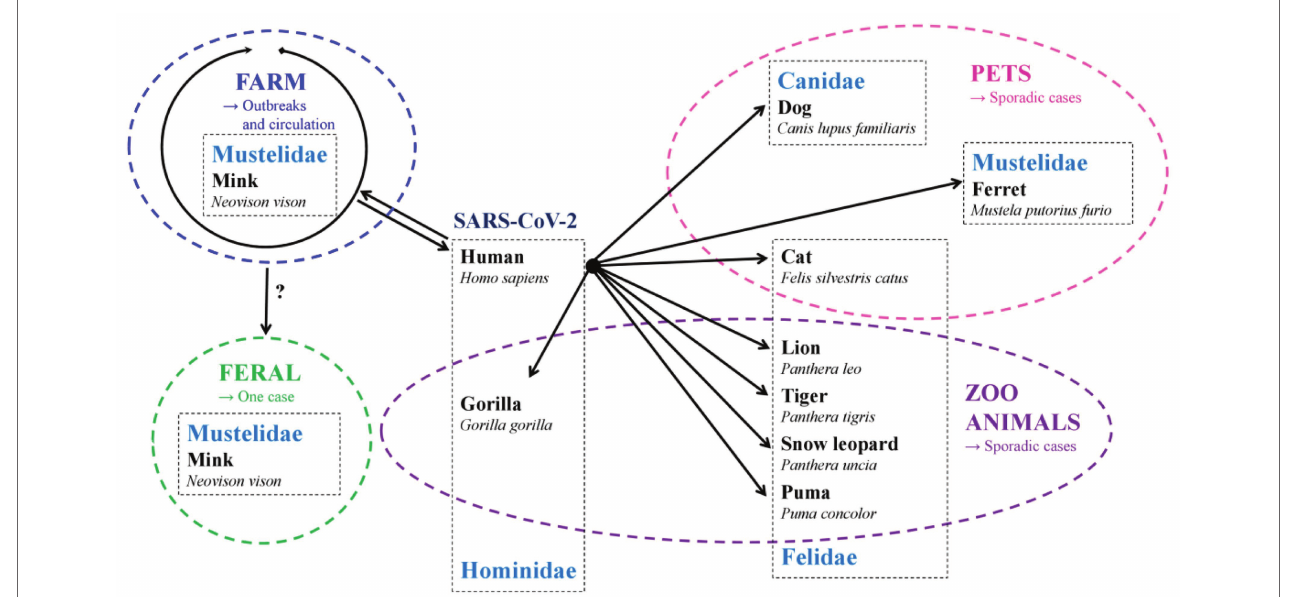
FIGURE 2 | Species naturally infected with SARS-CoV-2 and the origin of transmission ( →